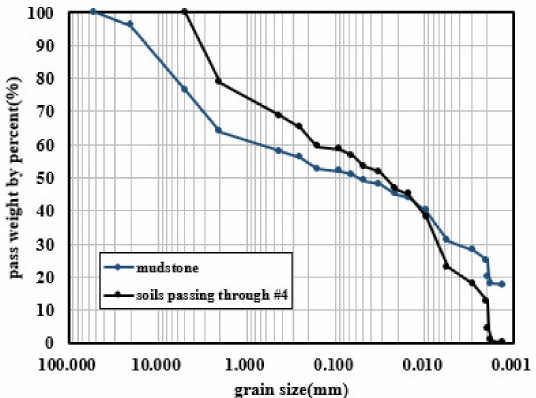
Figure 4. Particle size distribution curves of mudstone original soils and soils passing through #4.